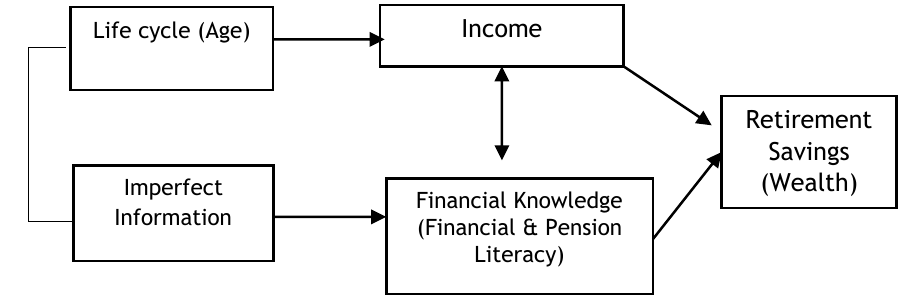
Figure 2. Conceptual